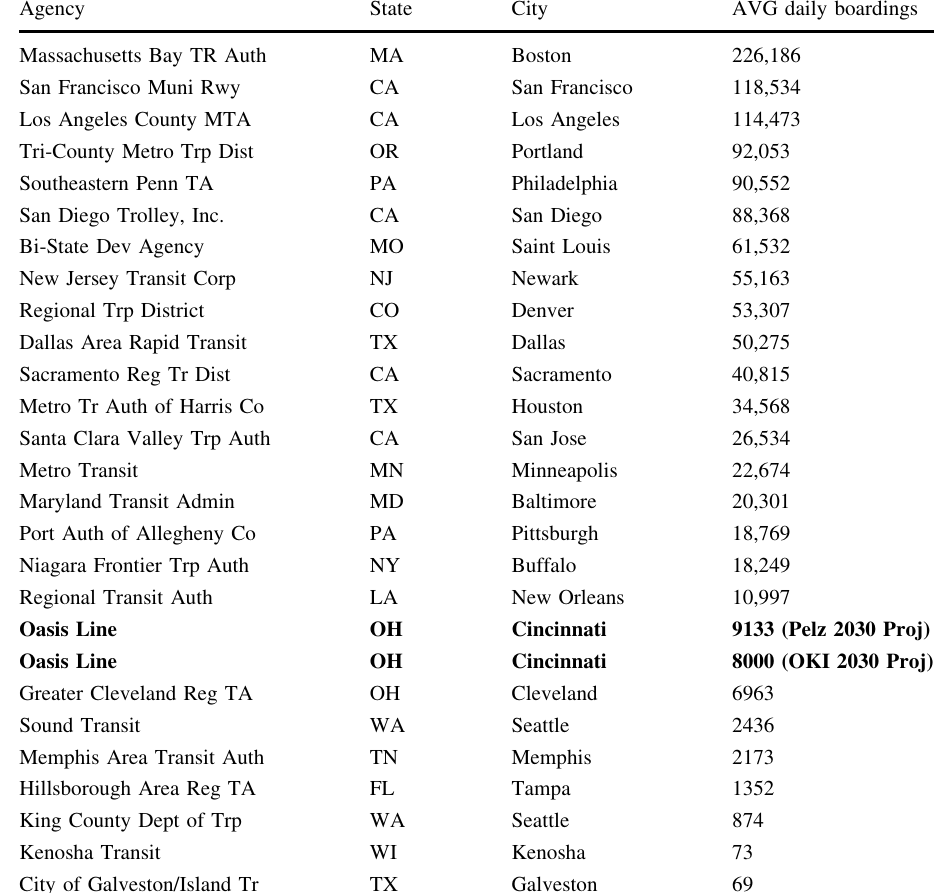
Table 2 Pelz and OKI Forecasts Ranked versus Existing Systems [12], [15,